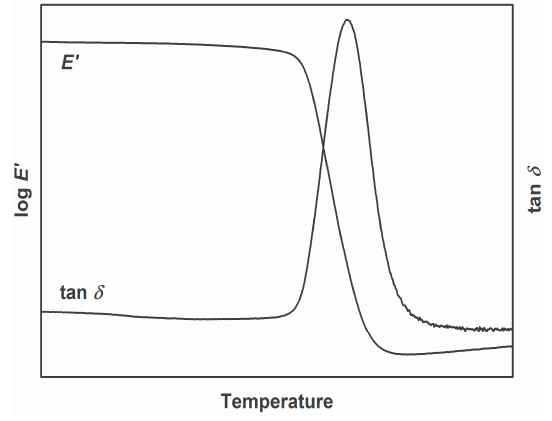
Figure 3. Representative DMA curve of a homogenous thermoset.